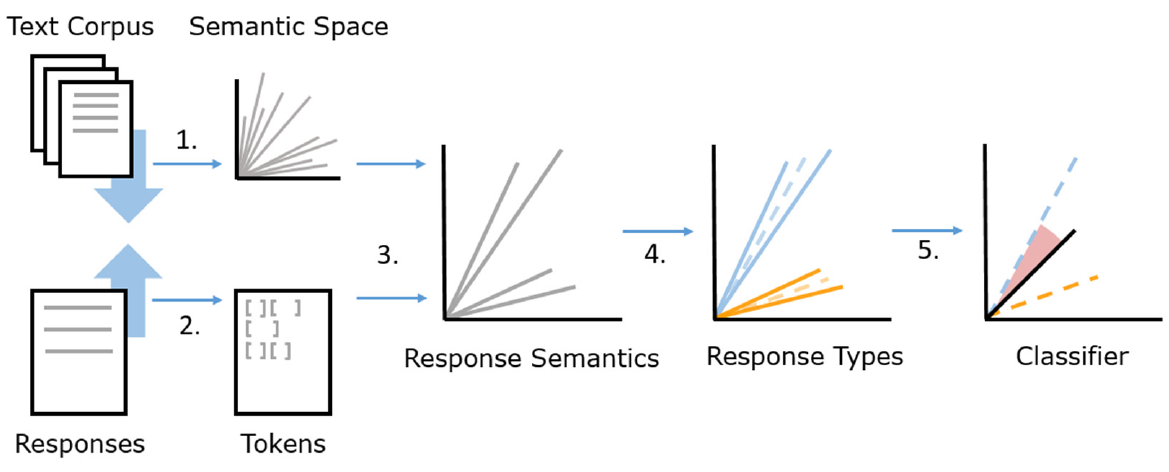
Figure 1. Overview of the response analysis pipeline for creating and applying a cluster model for automatic response coding.